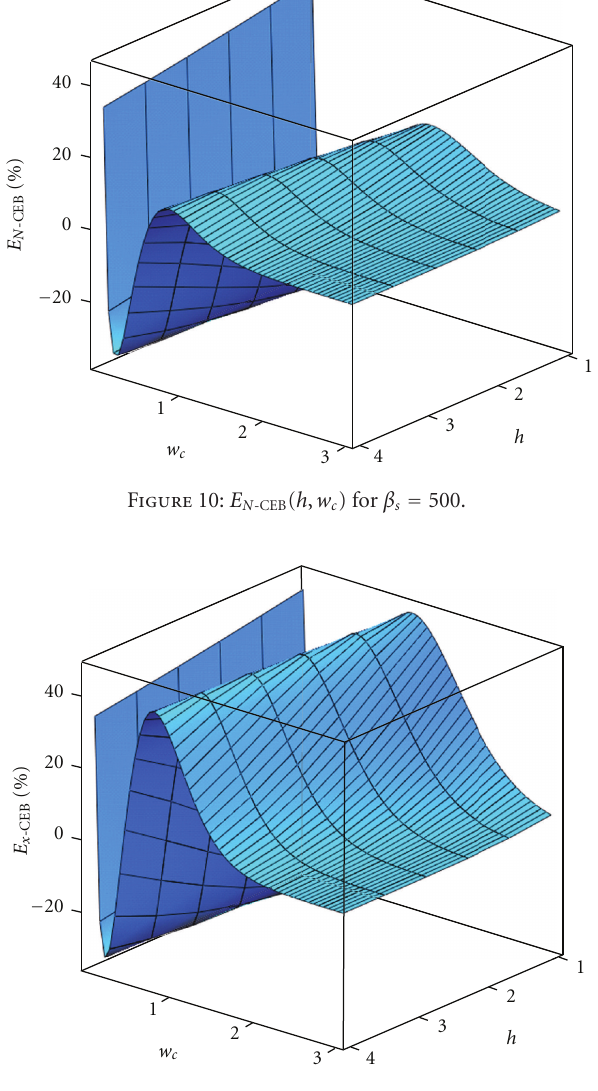
Figure 11: E x -CEB ( h , w c ) for β s = 500.